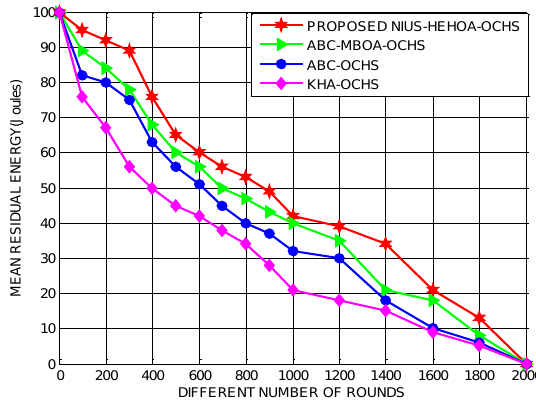
Figure 4 . Proposed NIUS-HEHOA-OCHS: Mean Residual Energy under different rounds